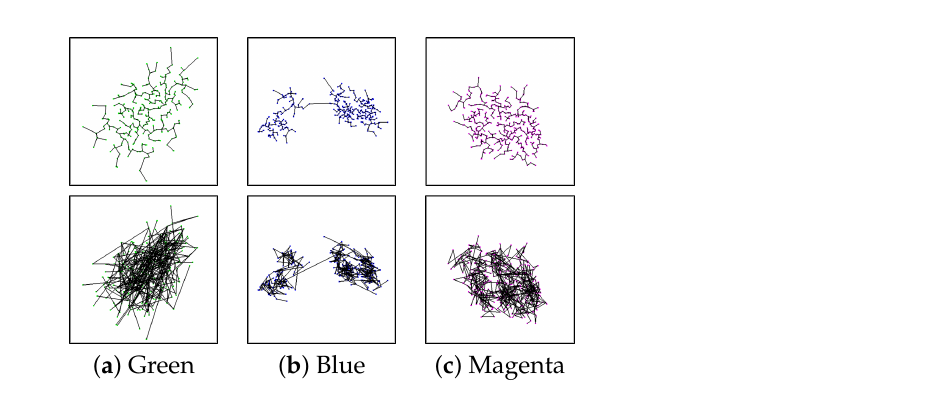
Figure 3. Scatterplots obtained by MDS-LDA with 2-D distance-based MST ( top row ) and N-D distance-based MST ( bottom row